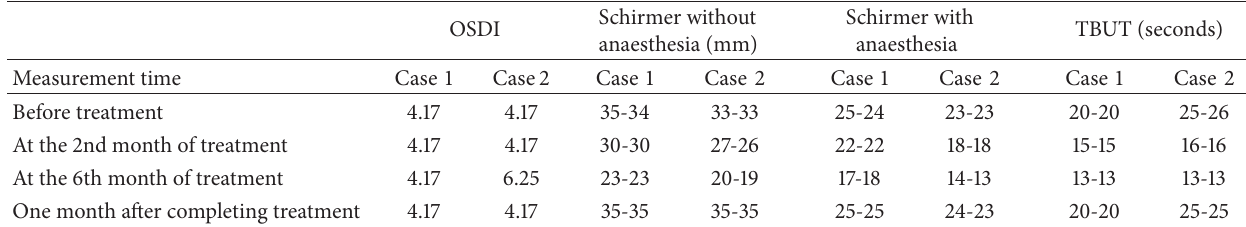
Table 1: OSDI questionnaire and tear function test results of the